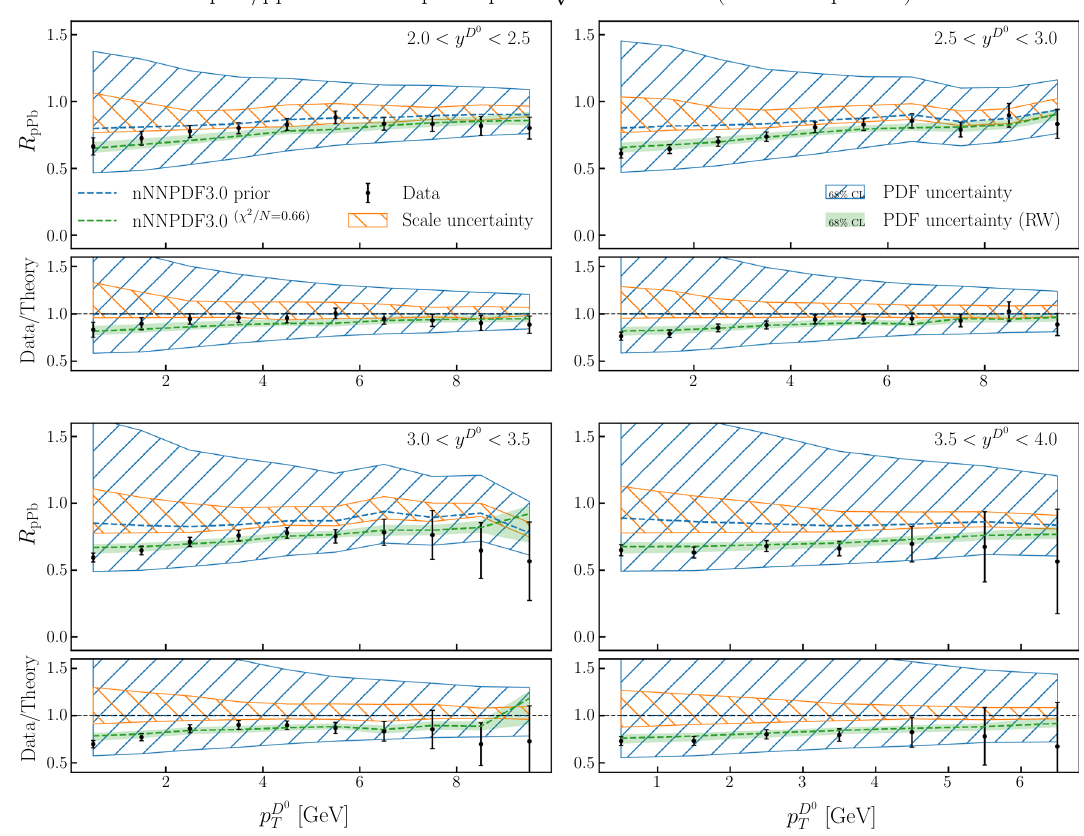
y D 0 as a function of the transverse momentum p D 0 . We display sepa- T rately the PDF and scale uncertainty bands, and the bottom panels show the ratios to the central value of the theory prediction based on the